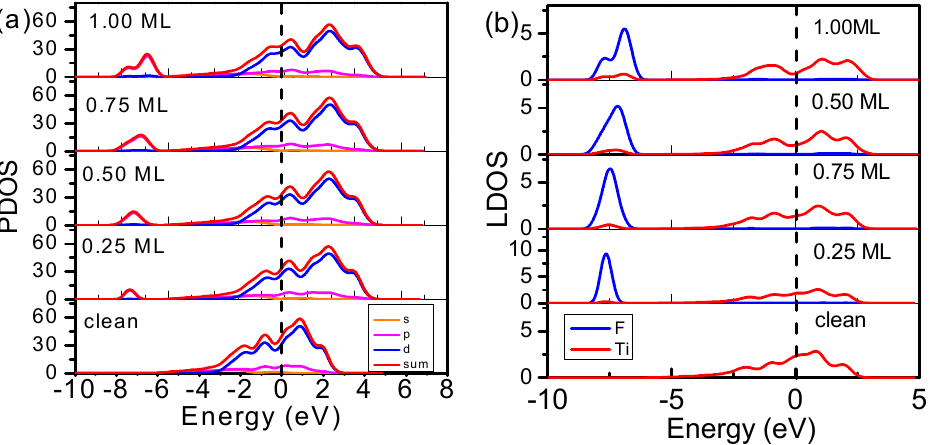
Figure 4. Ti(0001)-F coverage dependence of ( a ) valence projected DOSs and ( b ) valence local DOSs (LDOSs) of the most stable adsorption sites. The blue and red lines in represent the average LDOS per F and Ti atom in the surface area, respectively. E = 0 eV is the reference Fermi energy.